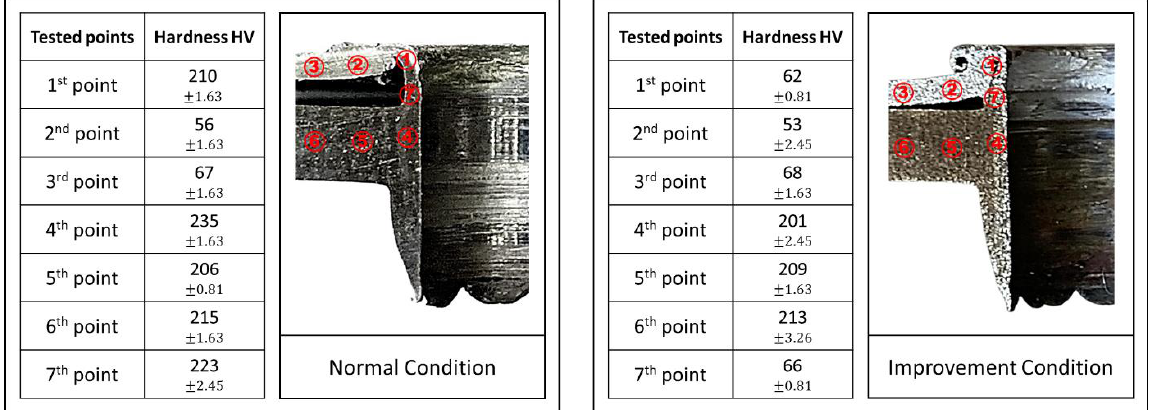
Figure 14. The hardness of seven tested points.